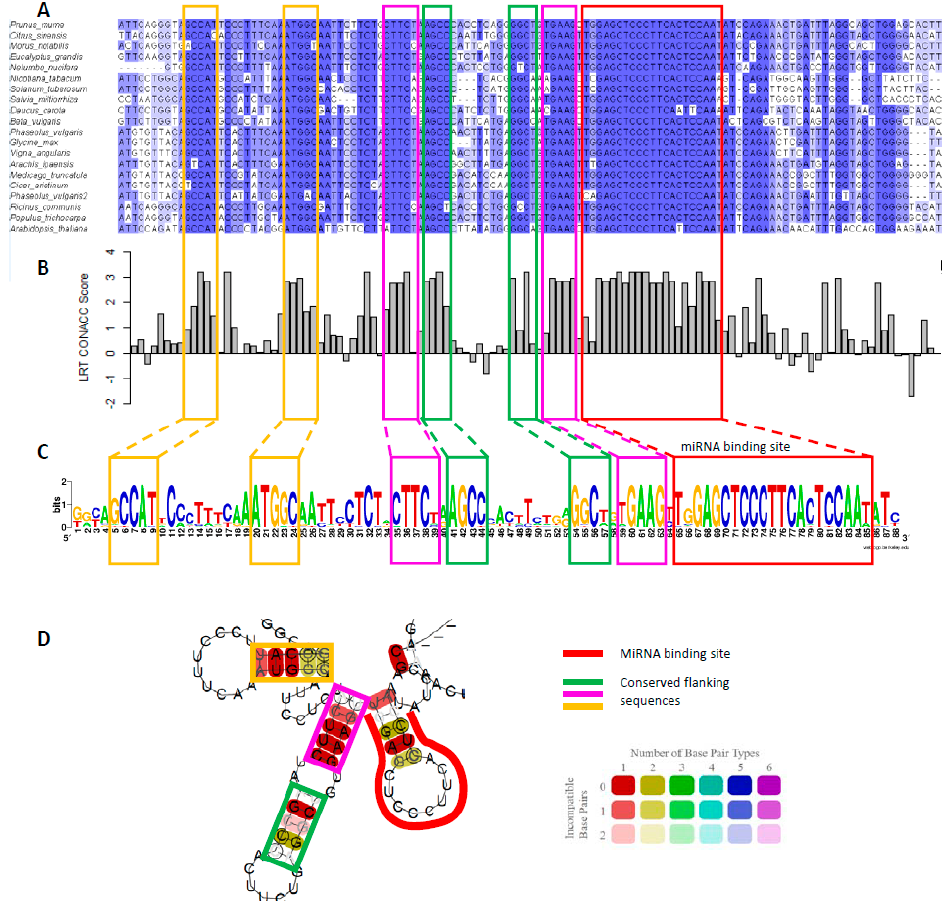
Figure 3. ( A ) Multiple alignment of MYB33 homologues from different plants species. The binding site is boxed in red, and the conserved flanking sequences in yellow, pink, and green throughout the Figure. ( B) phyloP score of the multiple sequence alignment of MYB33 sequences. A positive score denotes evolutionary conservation, whereas, a negative score denotes acceleration [54]. A likelihood ratio test (LRT) was used as the method to detect non-neutral substitution rates. Scores were generated using rPHAST [55]. ( C ) Sequence logo of the binding site and conserved flanking sequences generated using WebLogo [56]. ( D ) RNA secondary structure prediction of the consensus sequence from the multiple alignment in A. generated using RNAalifold [57] at 22 °C and default parameters. Colours represent the number of base pairs types (i.e., AU, UA, CG, GC, UG, GU), and hue the number of non-conserved nucleotides at that position.